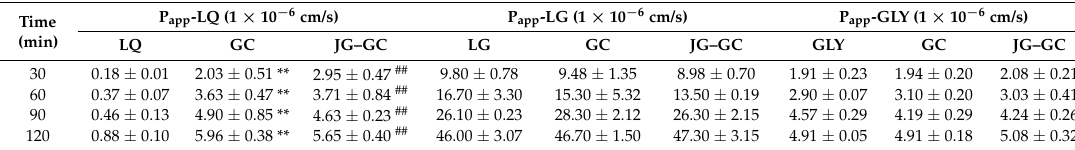
Table 2. The P app values for the analytes in different groups (mean ± SD, n = 3).